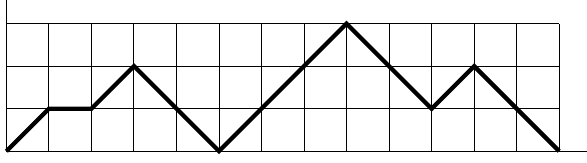
Fig. 1: The Motzkin path UHUDDUUUDDUDD and its corresponding permutations σ = (12) (11) 9 8 (10) (13) 5 3 2 4 6 1 7 (14) and σ (cid:48) = 2 4 1 6 3 5 8 (10) (12) 7 9 (14) (11) (13) lying respectively in S irr 14 (132) and S irr 14 (321)